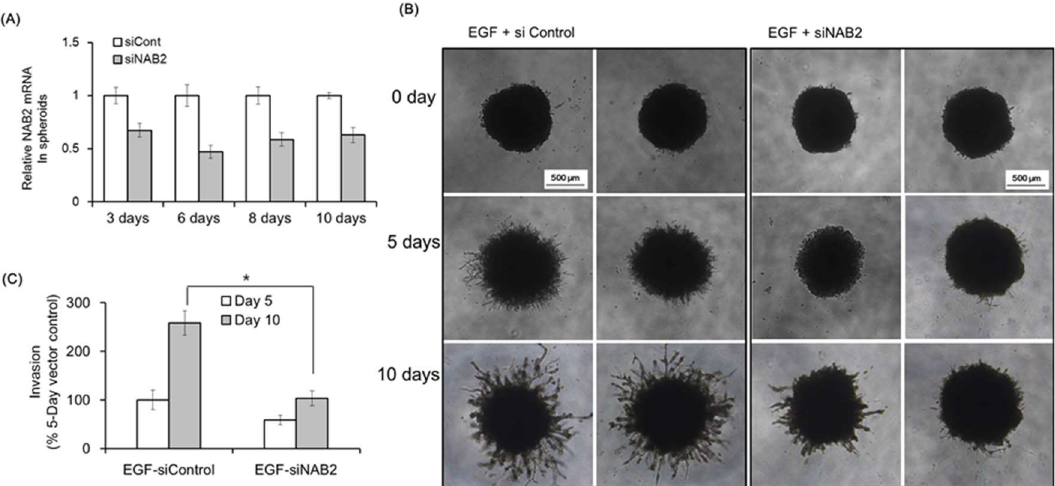
Figure 2. Effect of NAB2 on EGF-dependent head and neck squamous cell carcinoma (HNSCC) cell invasion. ( A ) NAB2 mRNA and protein expression following EGF treatment (50 ng/mL) for 24 h was analyzed in FaDU cells by qPCR and Western blot analysis. ( B ) FaDU cells were transfected with an siNAB2 mixture (40 nm/mL) for 48 h, after which the mRNA and protein expression of NAB2 were analyzed. ( C ) Two-dimensional Transwell Matrigel invasion assays were performed to analyze the effect of NAB2 knockdown, followed by EGF treatment, on FaDU cell invasion. Control siRNA- or siNAB2-transfected FaDU cells were added to each Matrigel-coated Transwell. After culturing for 48 h, the cells were washed twice with phosphate-bufferd saline and stained with 0.2% crystal violet in 10% ethanol (5× magnification). The cell invasion index was calculated as the difference between the number of invading cells in the siNAB2-transfected group compared to that in the control siRNA- transfected group (* p < 0.01). ( D ) Matrigel invasion assays using YD-10B cells were performed with the same conditions (5× magnification) (** p < 0.005). The results shown are from two or three independent experiments, with each bar representing the standard deviation.